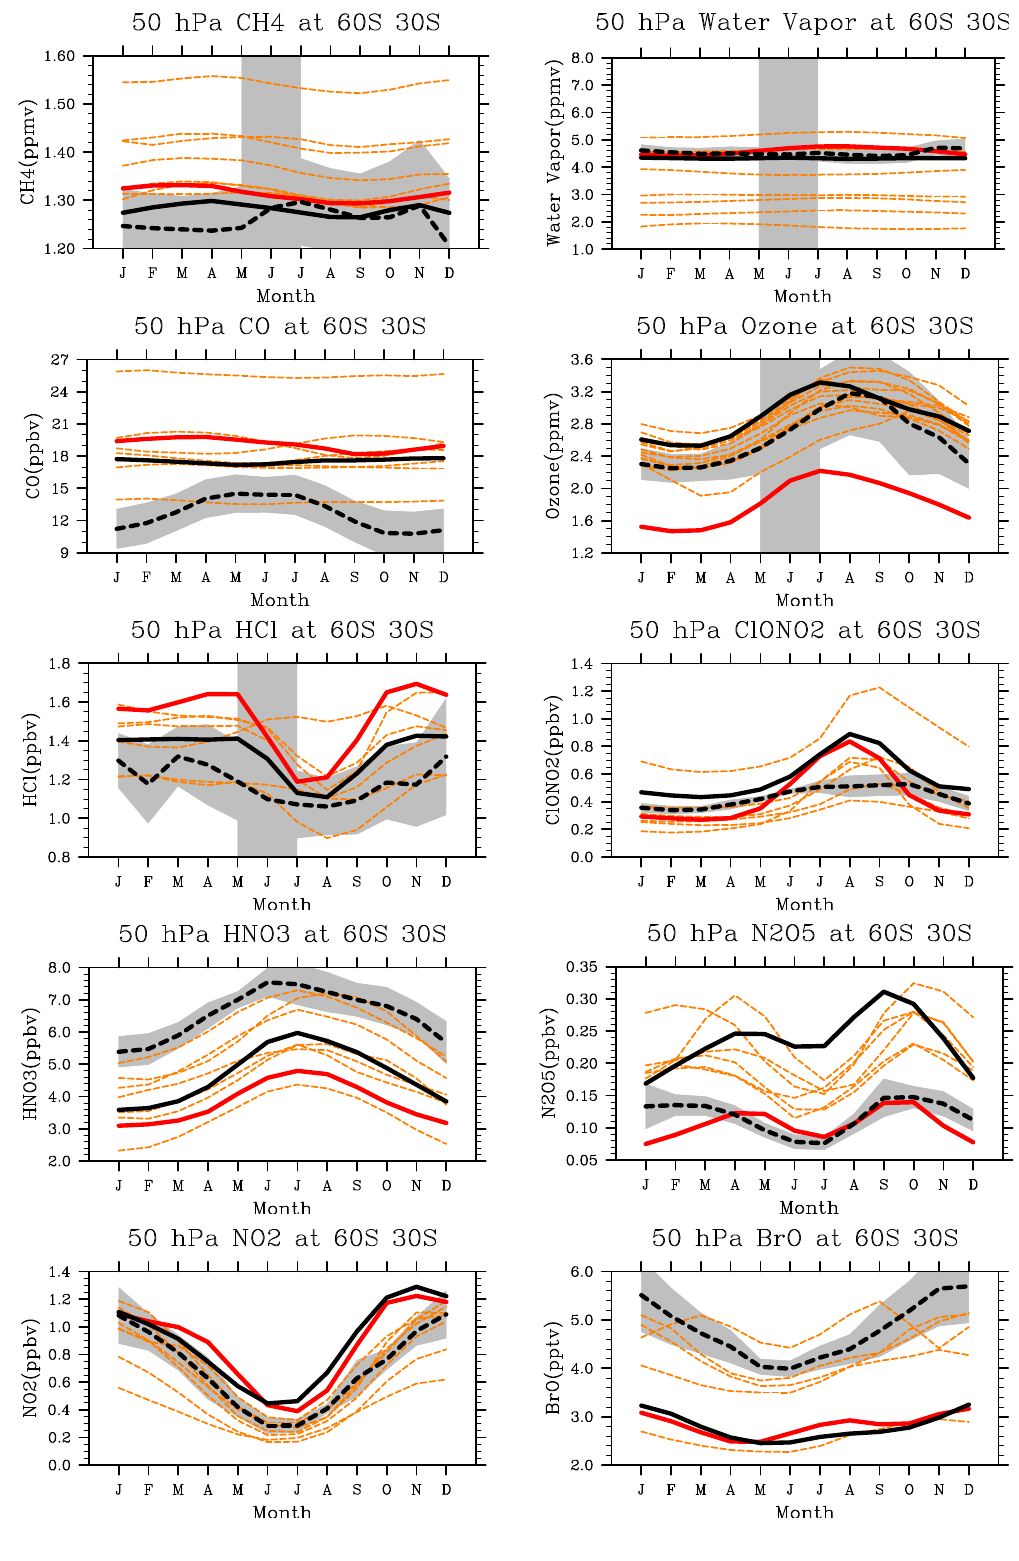
Fig. 13. Same as Fig. 12 at 50hPa, 60 ◦ S–30 ◦ S.